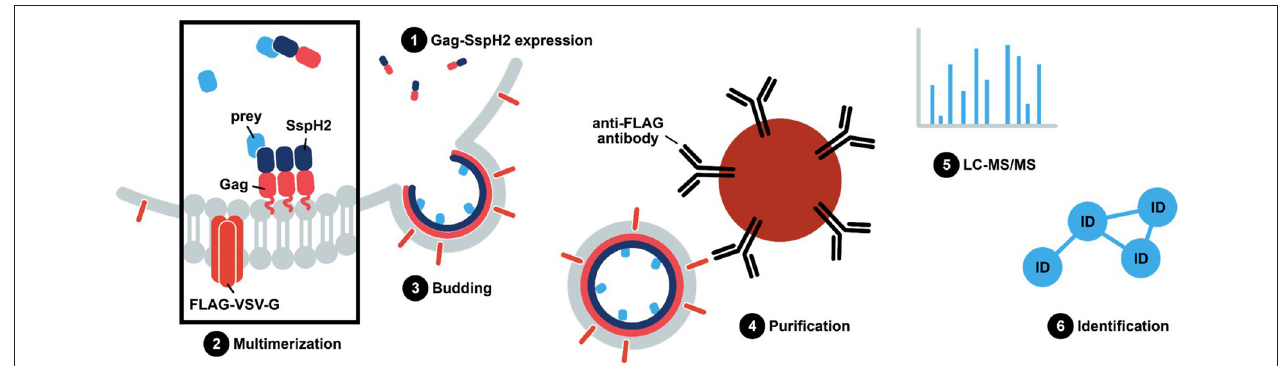
FIGURE 2 | S. Typhimurium SspH2 protein complex purification using Virotrap. In Virotrap, a fusion of the bait, e.g., effector protein of interest, to the C-terminus of the Gag polyprotein (myristoylated; pink zigzag line) of the human immunodeficiency virus type 1 (HIV-1) is transiently expressed in HEK293T cells. Along with the Gag-bait fusion, FLAG-tagged vesicular stomatitis virus glycoprotein (VSV-G) is expressed and becomes embedded in the plasma membrane. Gag facilitates multimerization and localization of the fusion protein at the plasma membrane, giving rise to virus-like particle (VLP) budding. Consequently, host preys are trapped inside VLPs that can be captured in the cell medium by anti-FLAG immunoprecipitation. LC-MS/MS-based analysis of the VLP content subsequently allows identification of significant bait co-enriched host